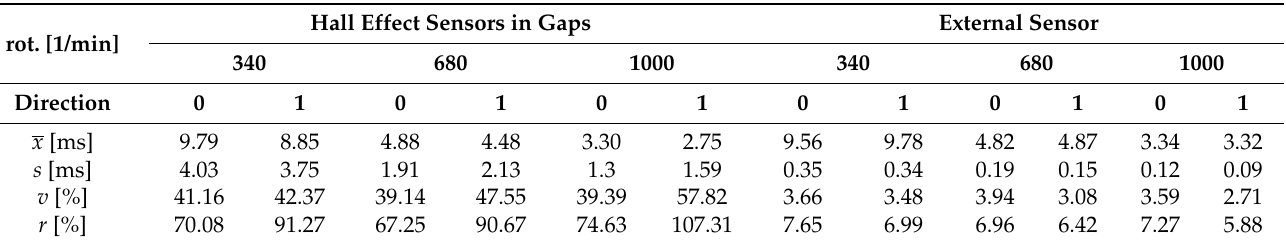
Table 4. Comparison of the symmetry of the signal determining the state of the rotor position for the hall effect sensor inside the engine and for the external sensor in the case of idling. rot.